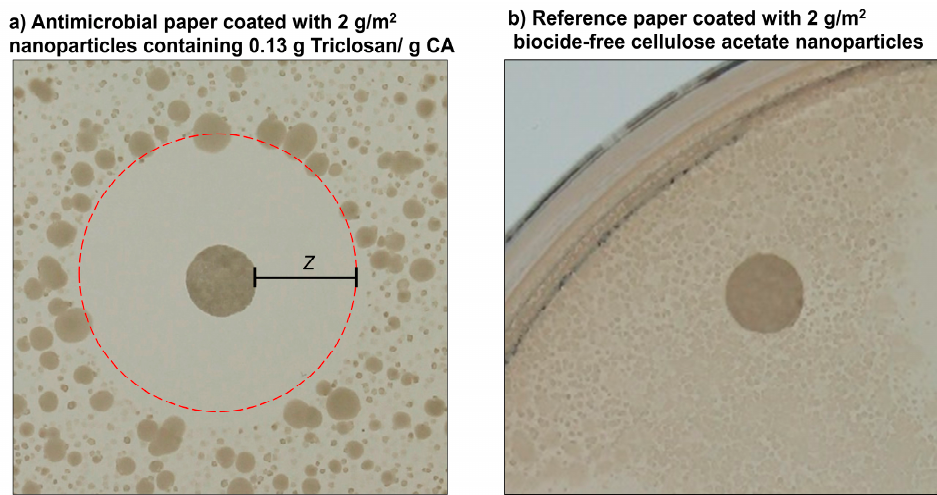
Figure 9. Paper substrates coated with 2 g/m 2 Triclosan-loaded ( a ) or biocide-free ( b ) nanoparticles incubated on agar plates containing spores of Bacillus subtilis at 37 °C for 24 h. Picture ( a ) shows the release of Triclosan from nanoparticles (weight ratio: 0.13 g Triclosan / g CA) leading to an area expressed as zone of inhibition ( Z ) around the paper substrate due to di ff usion of the biocide into the media, whereas biocide-free nanoparticles on a reference paper ( b ) show no suppression of bacterial